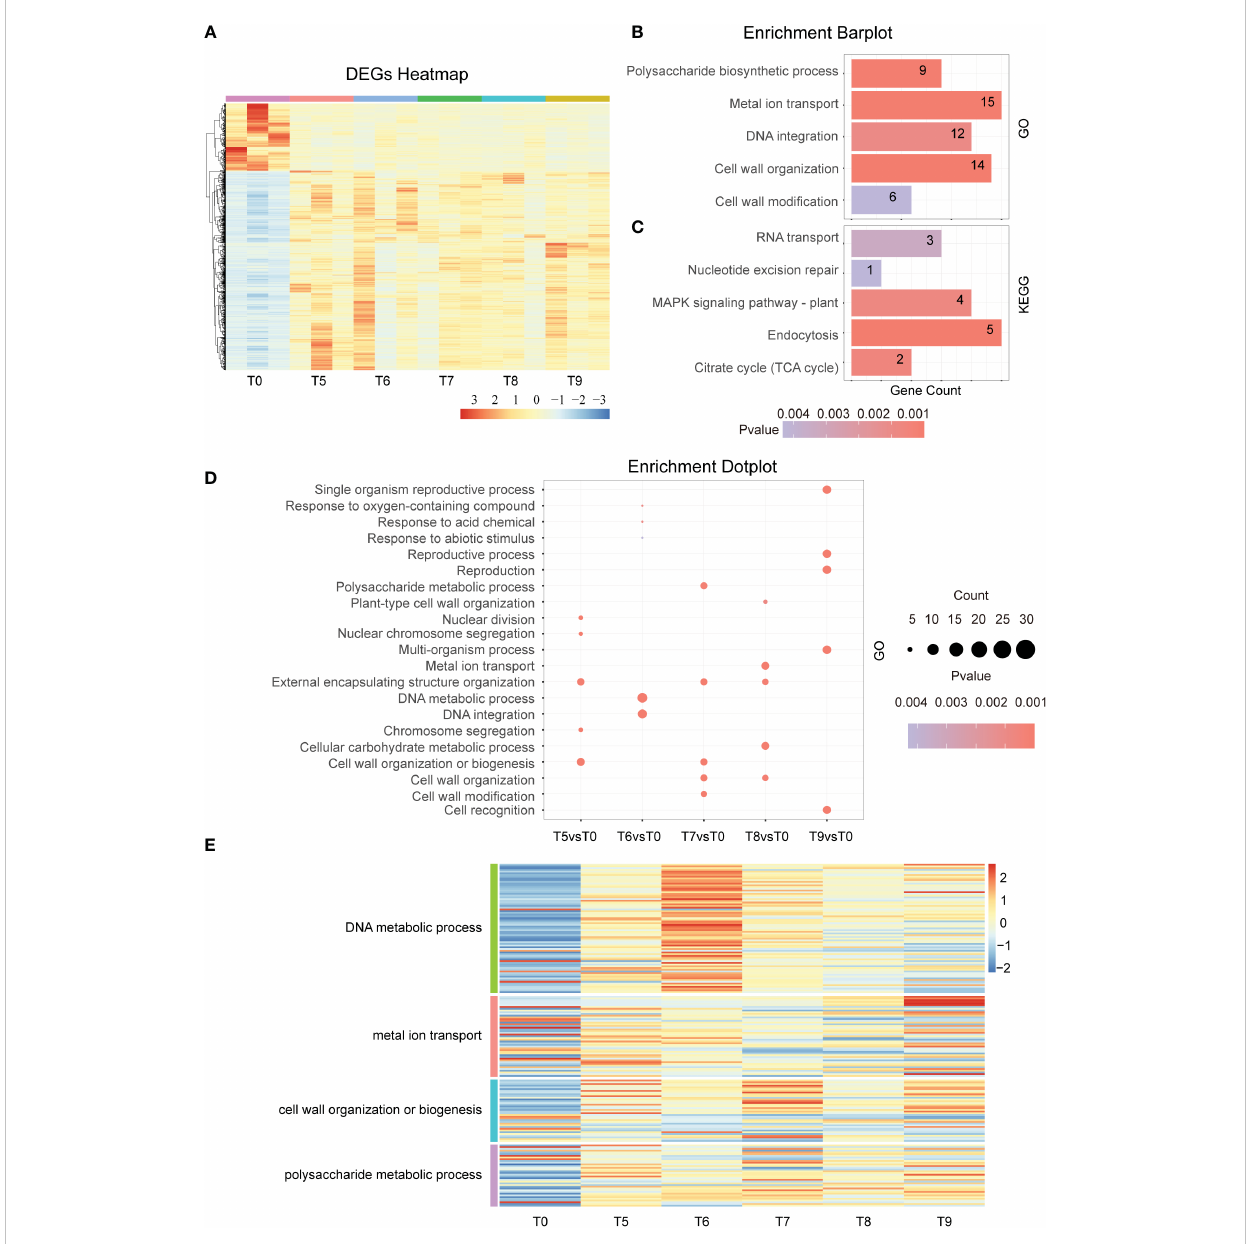
FIGURE 3 Differential gene expression in the middle stage of Cd treatment. (A) . Hierarchical clustering heat map showing the gene expression of a total of 18 samples at each time point during the middle phase of Cd stress treatment (T0 and T5-T9). (B) . GO term enrichment analysis of common DEGs after Cd treatment (T5vsT0, T6vsT0, T7vsT0, T8vsT0, and T9vsT0). The top 5 entries for each time signi fi cance were selected for statistical analysis. (C) . KEGG analysis of common DEGs after cadmium treatment (T5vsT0, T6vsT0, T7vsT0, T8vsT0, and T9vsT0). The top 5 entries for each time signi fi cance were selected for statistical analysis. (D) . GO enrichment results of differentially expressed genes at each time point (T5-T9) in the middle phase of the Cd stress response. The top 3 entries for each time signi fi cance were selected for statistical analysis. (E) . The heat map shows the gene expression in DNA metabolic process, metal ion transport, cell wall organization or biogenesis, and polysaccharide metabolic process at the middle stage of cadmium stress